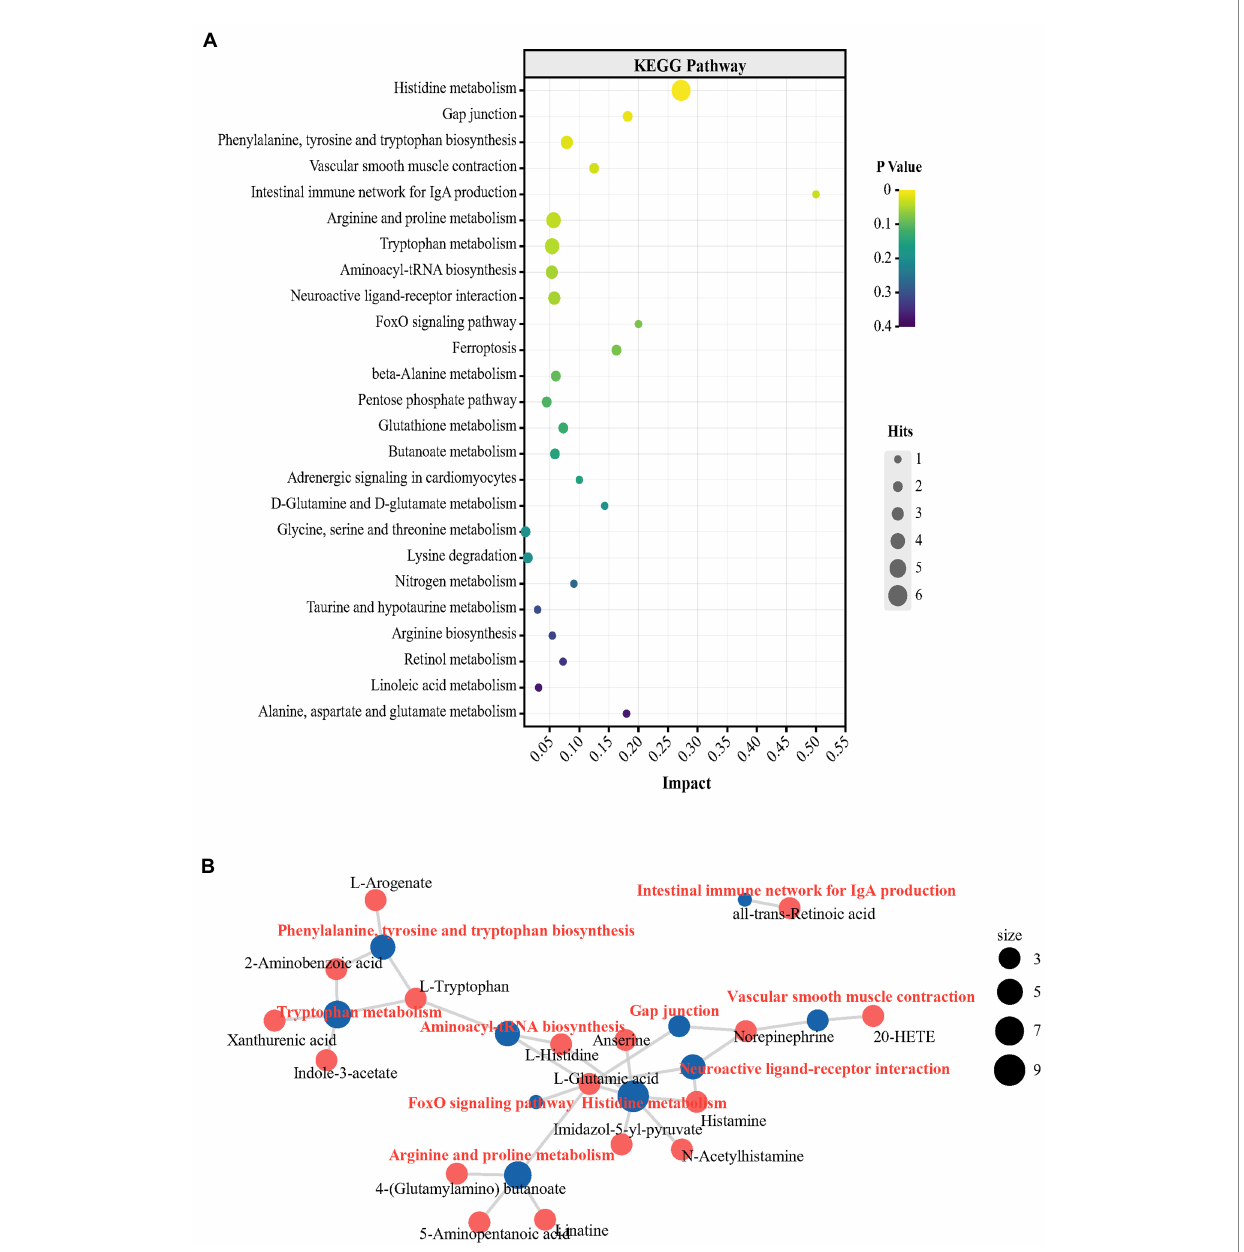
FIGURE 6 The turbulence of metabolic profile in hippocampus of FP bird. (A) Bubble chart from the top 25 KEGG pathways enriching with the differential metabolites in plasma; (B) The network plot from the top 10 KEGG pathways enriching with the differential metabolites in